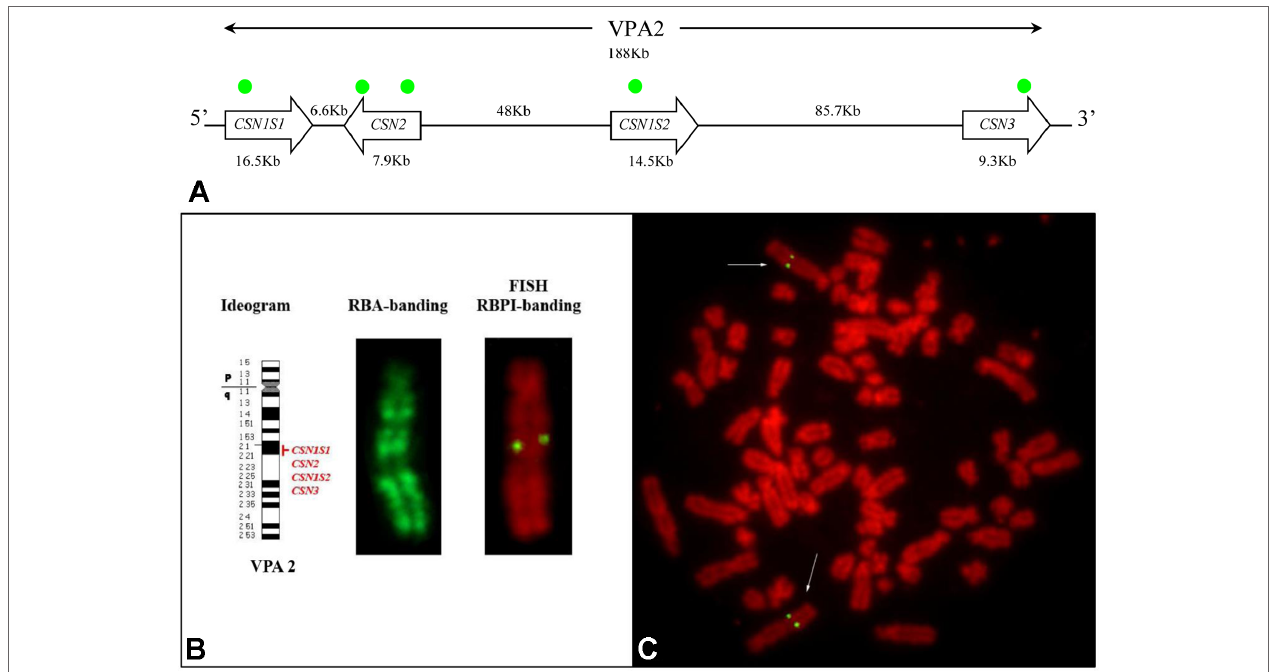
FIGURE 4 | Casein cluster organization and genes mapping in alpaca (VPA). (A) Schematic representation of the genomic arrangement of the casein loci along the chromosome. The approximate position of the gene-specific probes used for the mapping is indicated with green dots. (B) Diagrammatic representation of VPA 2, RBA-banding, and RBPI staining. ( C ) Fluorescence in situ hybridization obtained by using CSN1S1 , CSN2 , CSN1S2 , and CSN3 gene probes shows specific signal on chromosome 2q2.1. Fluorescein isothiocyanate signals were superimposed on RBPI-banding (R-banding using early BrdU-incorporation and propidium iodide